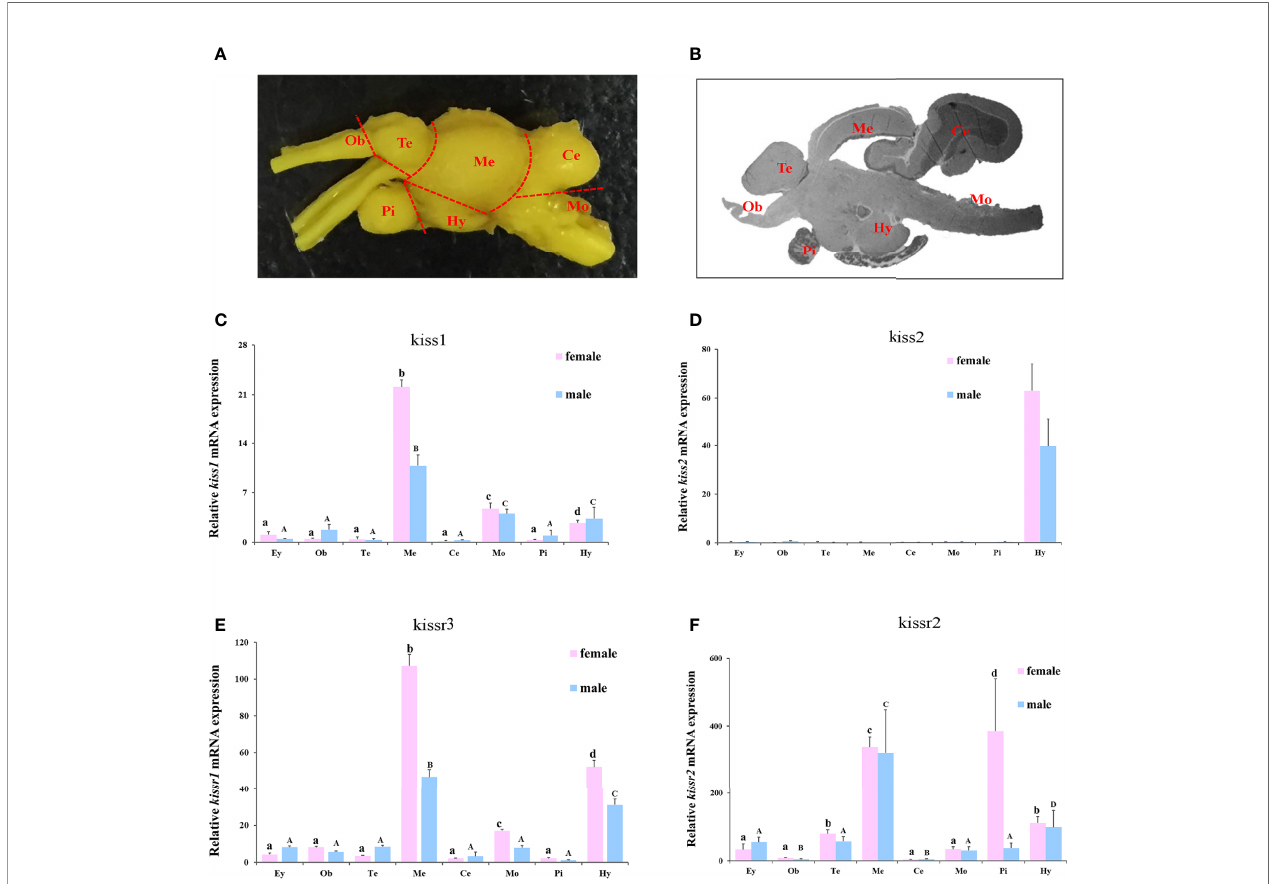
FIGURE 5 | The turbot brain areas and expression of kiss / kissr genes in different brain areas and eyes. (A) morphology of turbot brain areas. (B) histology of turbot brain areas. (C) kiss1 . (D) kiss2 . (E) kissr3 . (F) kissr2 . The relative abundance of kiss / kissr genes were expressed as mean ± SEM (n = 3). Ey, eye; Ob, olfactory bulbs; Te, telencephalon; Me, mesencephalon; Ce, cerebellum; Hy, hypothalamus; Pi, pituitary gland; Mo, medulla oblongata. The different uppercase letters in the fi gure represent statistical signi fi cance ( p < 0.05 ) in male. The different lowercase letters in the fi gure represent statistical signi fi cance ( p < 0.05 ) in